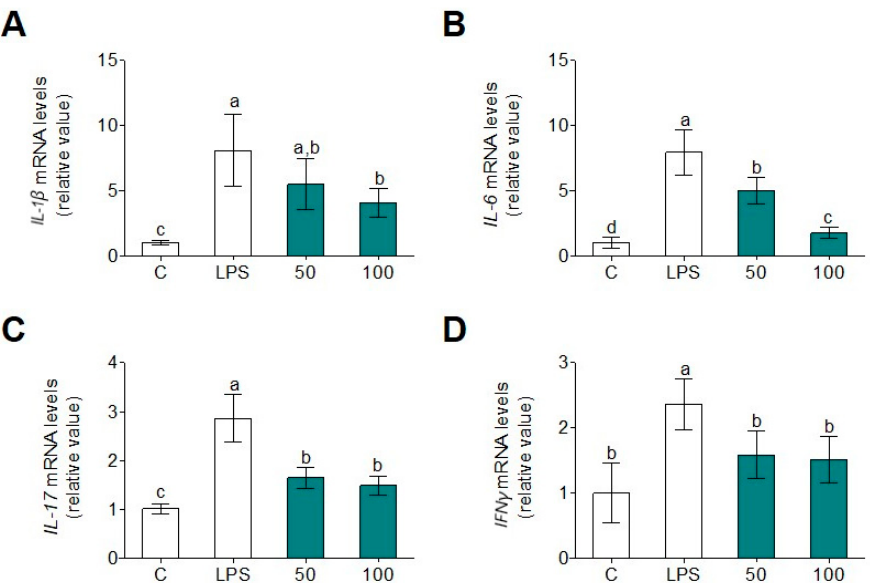
Figure 5. Gene expression of IL-1 β ( A ), IL-6 ( B ), IL-17 ( C ), and IFN γ ( D ) in primary human monocytes after 24 h incubation with or without LPS (100 ng / mL) and WGPH45A at 50 and 100 µ g / m. Values are presented as means ± SD ( n = 3) and those marked with different letters are significantly different ( p < 0.05).